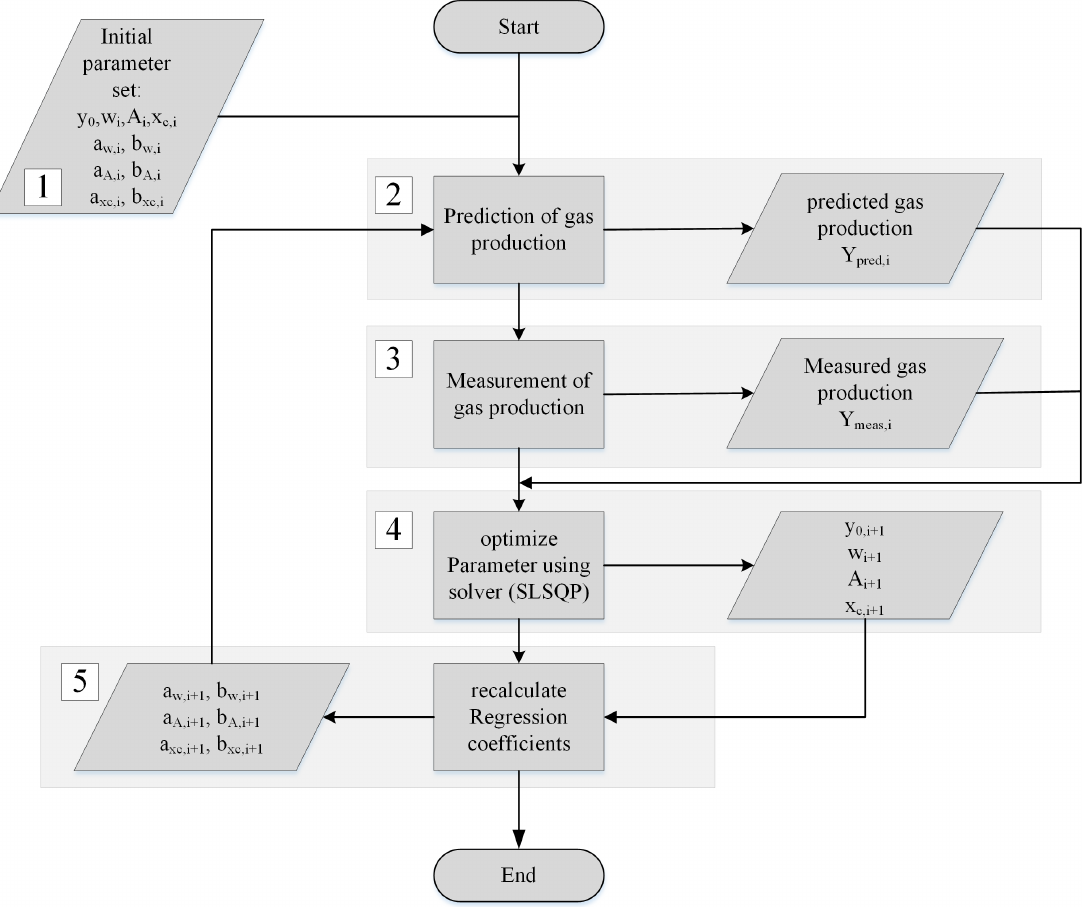
Figure 6. Proposed model scheme for prediction of gas production rates consisting of 5